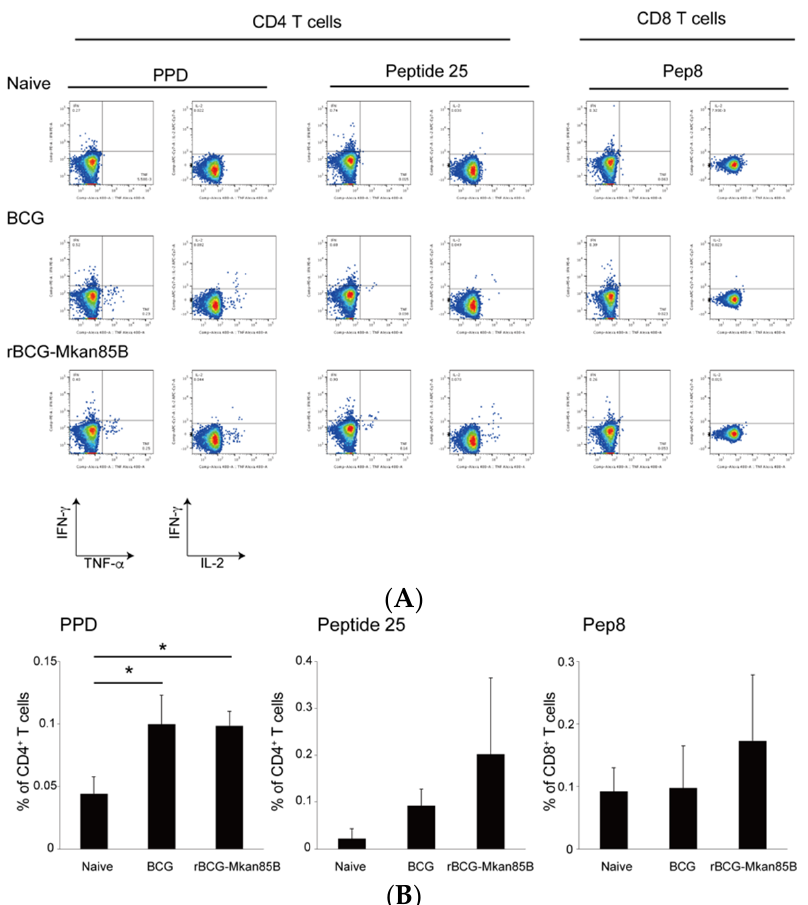
Figure 4. M. kansasii -specific polyfunctional CD4 + and CD8 + T cells in BCG- or rBCG-Mkan85B-vaccinated CB6F1 mice. (A) A representative fluorogram of epitope-specific polyfunctional CD4 + and CD8 + T cell inductions in splenocytes from unvaccinated and vaccinated mice infected with M. kansasii ; TNF is shown on the x -axis and IFN- γ is shown on the y -axis. (B) Polyfunctional CD4 + and CD8 + T cells from unvaccinated and vaccinated CB6F1 mice infected with M. kansasii . Polyfunctional CD4 + T cell induction by stimulation with PPD (left panel), polyfunctional CD4 + T cell induction by stimulation with peptide 25 (middle panel), and polyfunctional CD8 + T cell induction by stimulation with Pep8 (right panel) in unvaccinated, BCG-, and rBCG-Mkan85B-vaccinated mice are shown. The data represent two independent experiments with three to four mice per group. The error bars represent the SD. * p < 0.05.